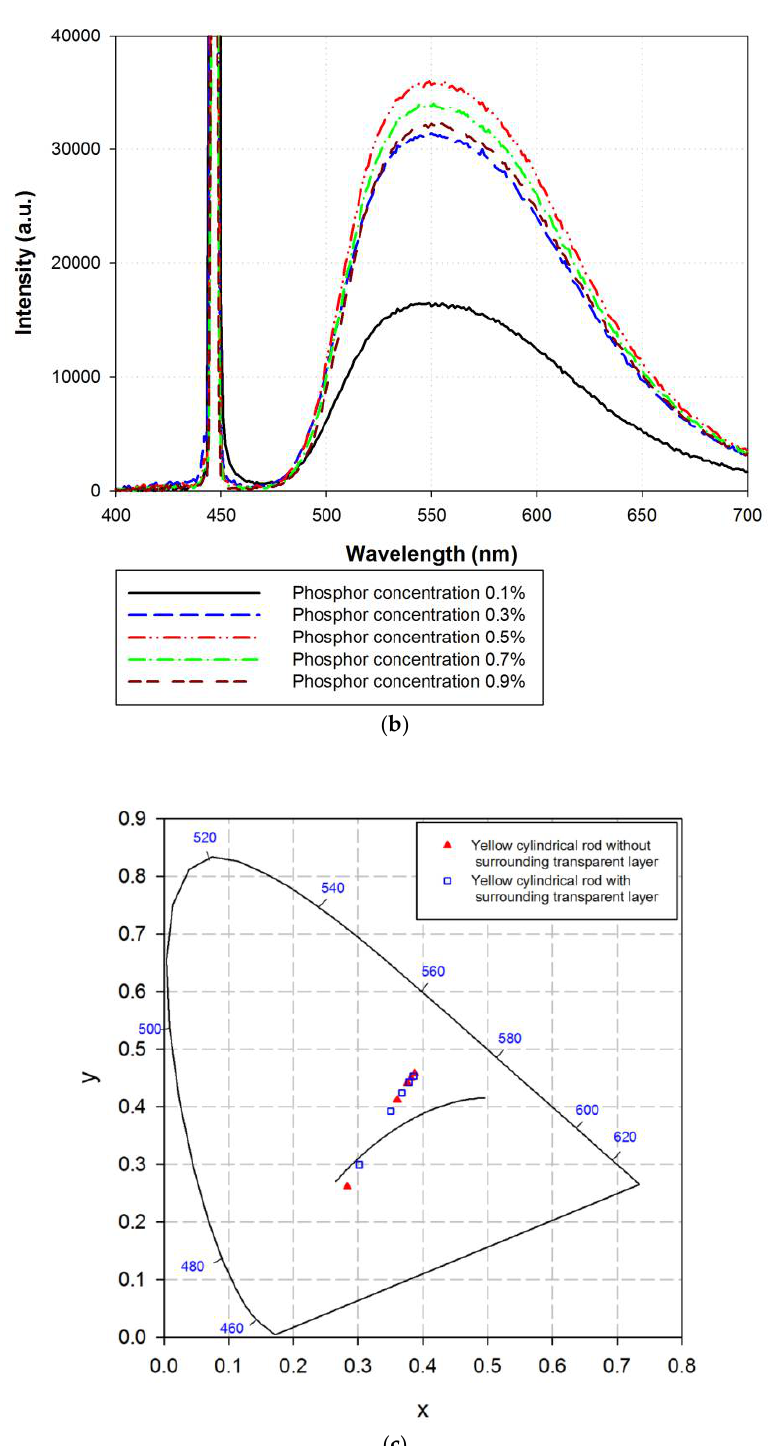
Figure 4. Emission spectra of cylindrical rod containing yellow phosphor ( a ) without and ( b ) with surrounding transparent layer for laser-driven white lighting. ( c ) CIE chromaticity coordinates of cylindrical rod containing yellow phosphor with or without surrounding transparent layer for laser-driven white